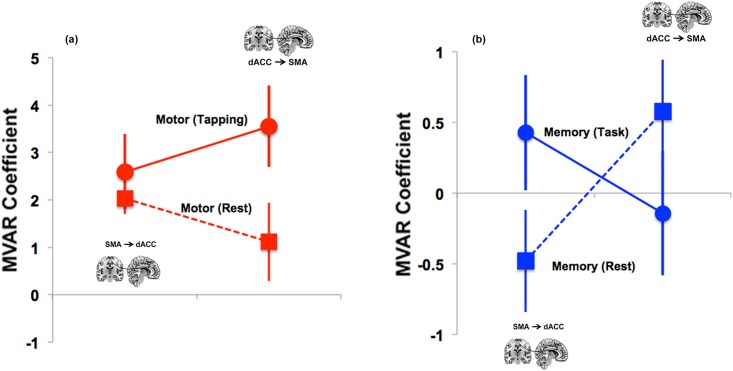
(a) Directed connectivity analyses within the Motor task assessed effects of State (Task vs. Rest) and Direction. As seen, a State x Direction interaction was observed. The dACC → SMA connectivity increased when participants transitioned to the task-active state, relative to the rest state (t = 3.73, p < .05, corrected). (b) The depicted crossover for the interaction in the Memory condition was not significant (corrected). Error bars are ± sem.